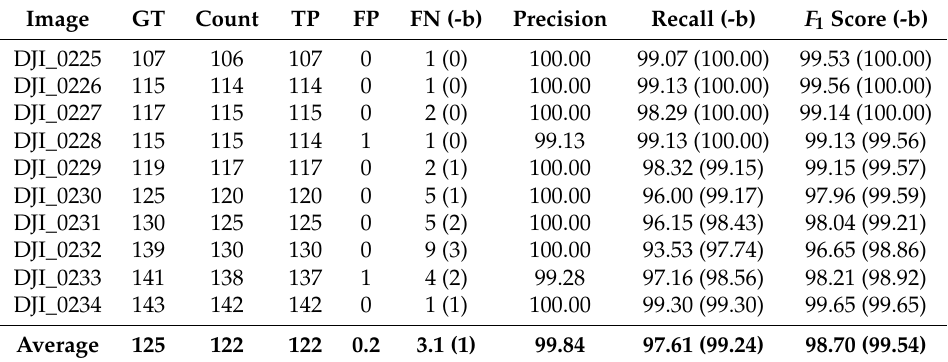
Table 2. Classification performance metrics for each image (GT: ground-truth, TP: true positive, FP: false positive, FN: false negative, (-b): excluding errors in the borderline).